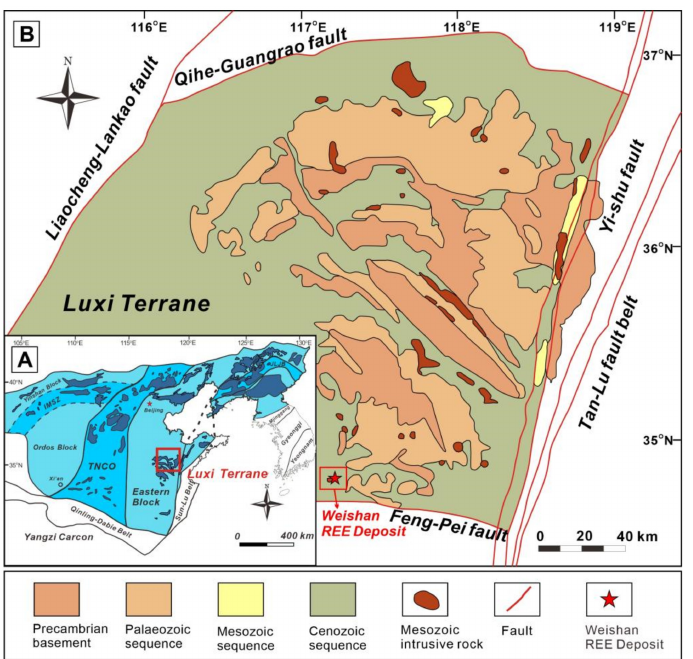
Figure 1. ( A ) Geological sketch map of the North China Craton [30]. ( B ) Geological sketch map of the Luxi Terrane